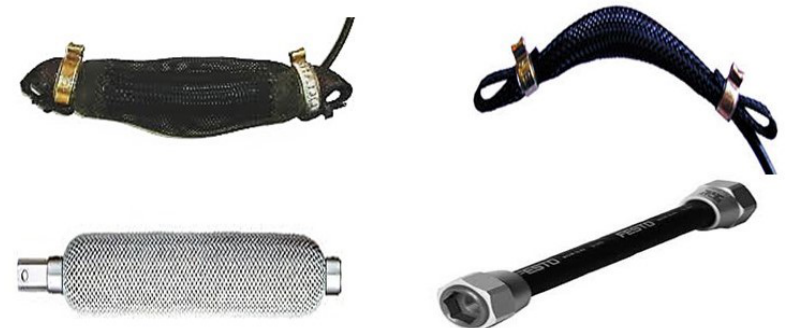
Figure 4. Different versions of the McKibben Muscle